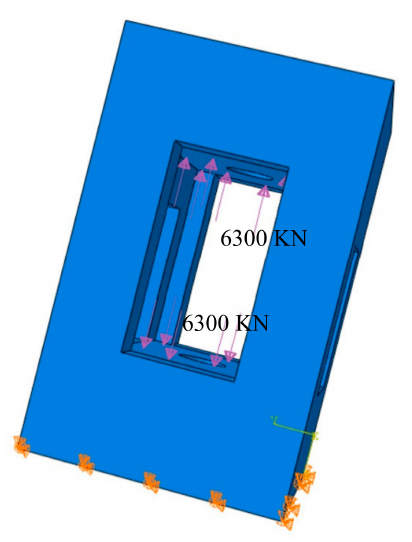
Figure 3. Boundary conditions of the COF machine.